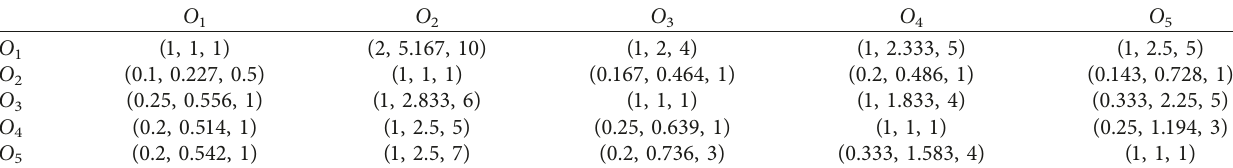
Table 4: Fuzzy aggregated decision matrix.